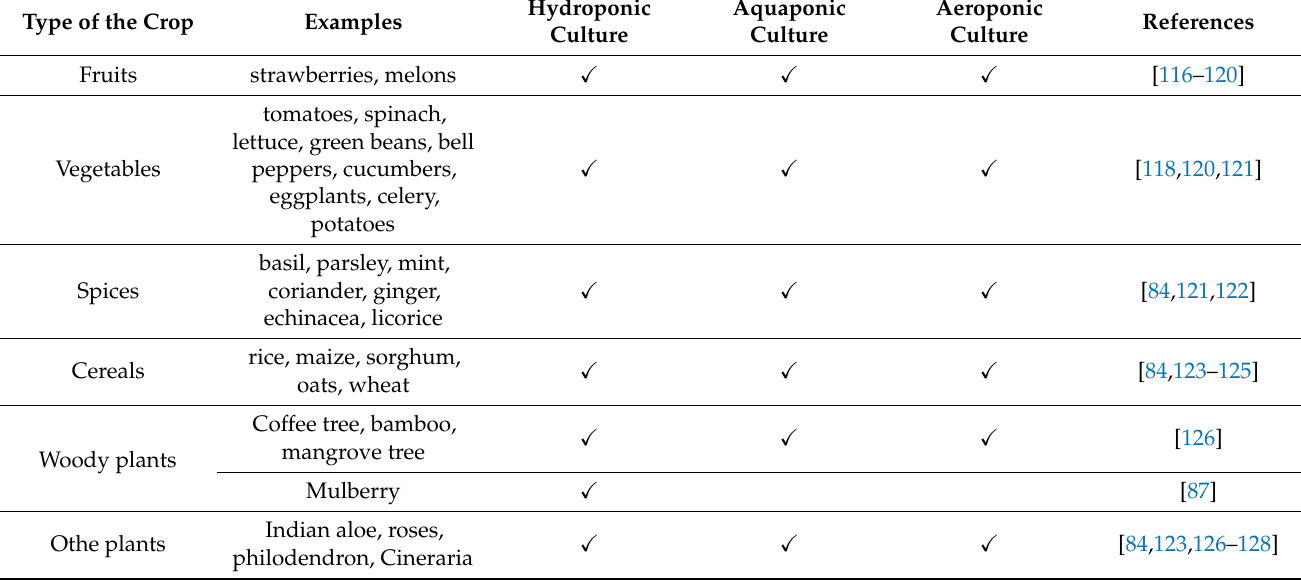
Table 2. Examples of crops successfully grown in vertical farming